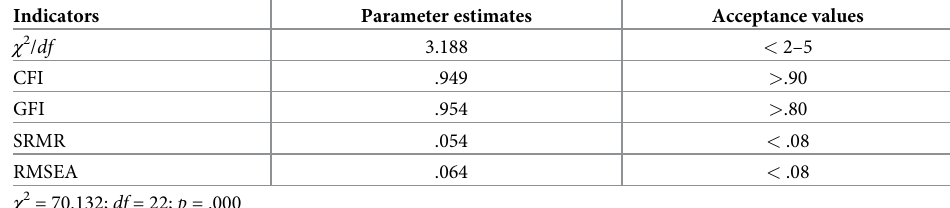
Table 5. Confirmatory factor analysis results for a three-factor model of 9 social media science communication goals ( N = 314).